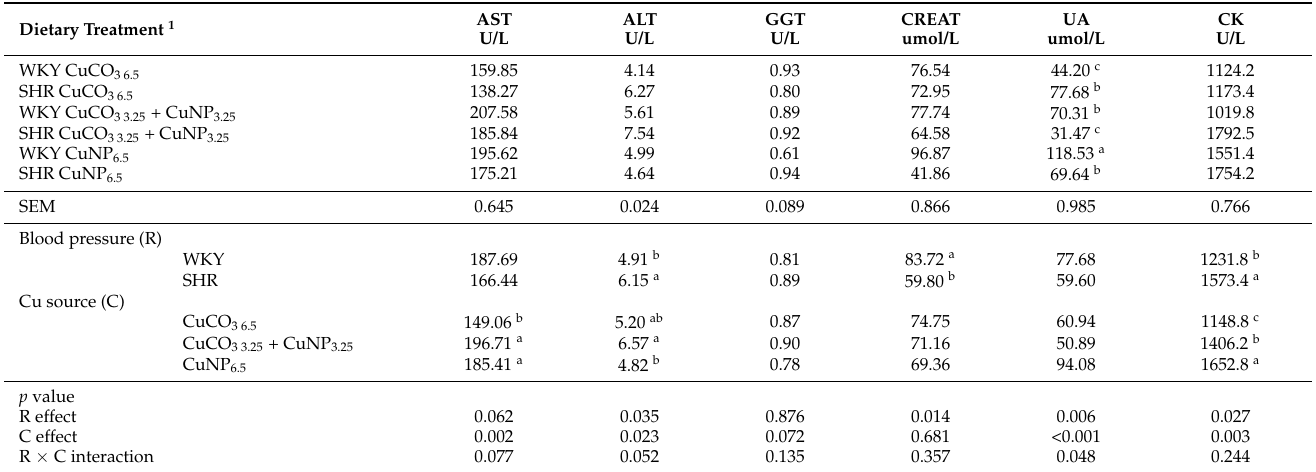
Table 1. Blood biochemical parameters.